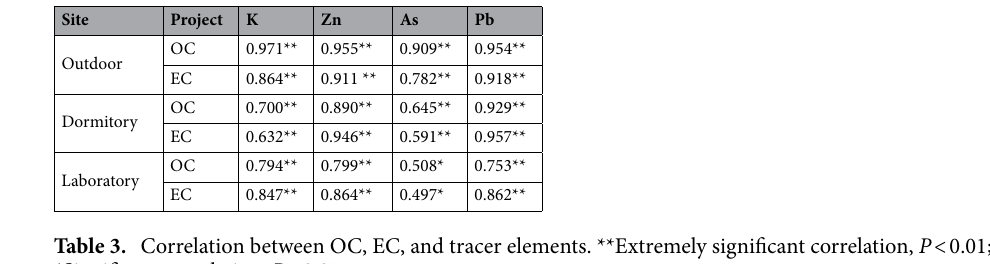
Table 3. Correlation between OC, EC, and tracer elements. **Extremely significant correlation, P < 0.01; *Significant correlation, P <